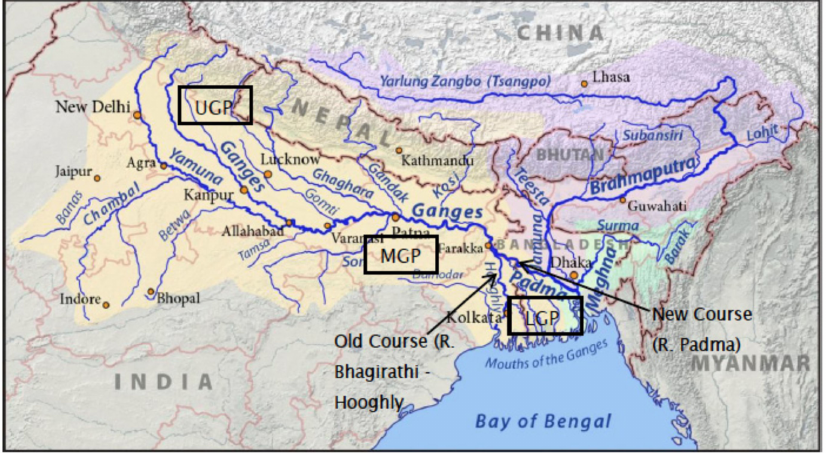
Figure 1. Ganges-Padma River Basin. Here, UGP, MGP, and LGP indicate the Upper Ganga Plain, Middle Ganga Plain, and Lower Ganga